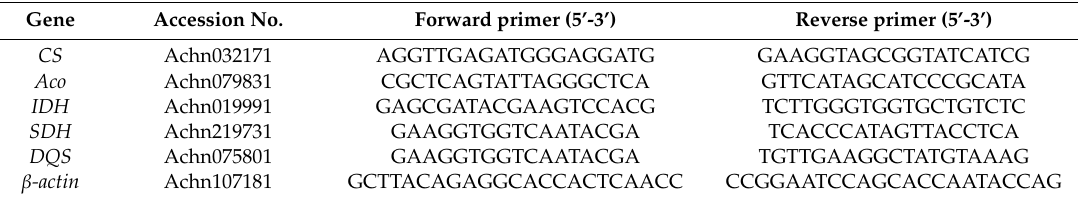
Table 2. Primers used for quantitative real-time